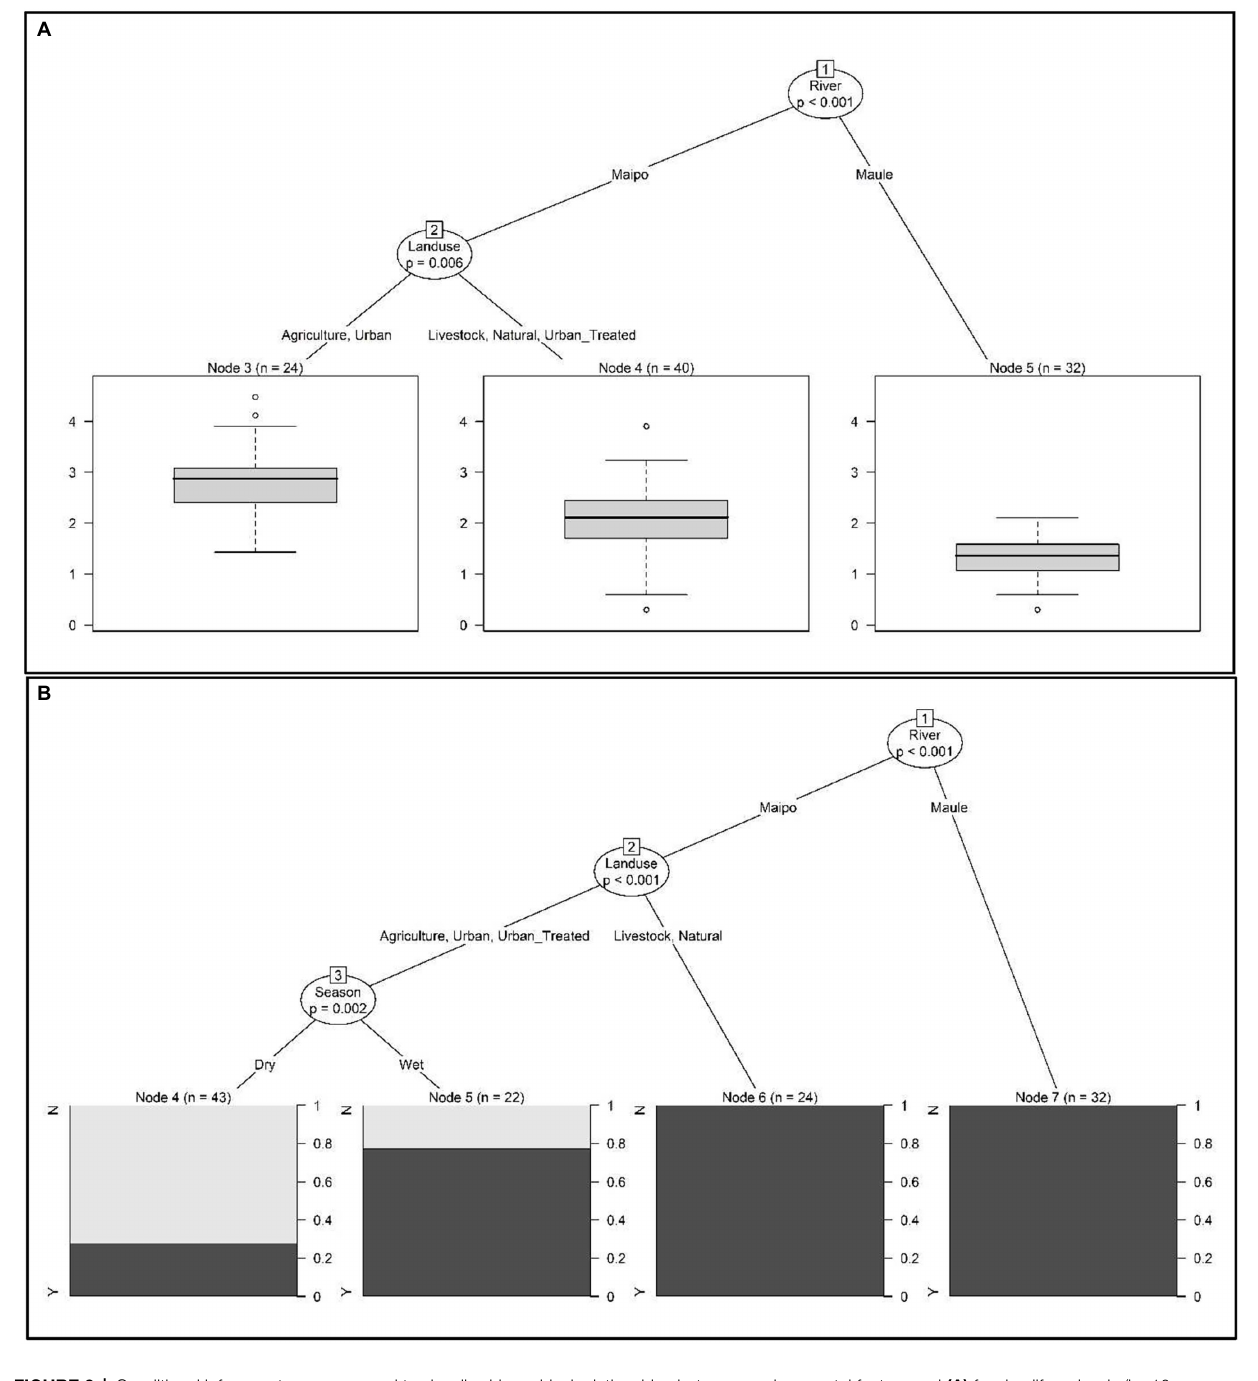
FIGURE 2 | Conditional inference trees were used to visualize hierarchical relationships between environmental factors and (A) fecal coliform levels (log10 MPN/100-ml) in water samples, and (B) if fecal coliform levels were above or below the Chilean water quality standard (i.e., above or below 1,000 CFU/100-ml). In (A) the boxplot shows the distribution of log10 fecal coliform levels in samples that met the given condition. In (B) the black bar in each plot shows the probability of the water sample being non-compliant with the Chilean water quality standard when the given conditions were met. For example, fecal coliform levels were highest in Maipo River samples collected from site with predominantly agricultural and urban land uses (that were not at a wastewater discharge